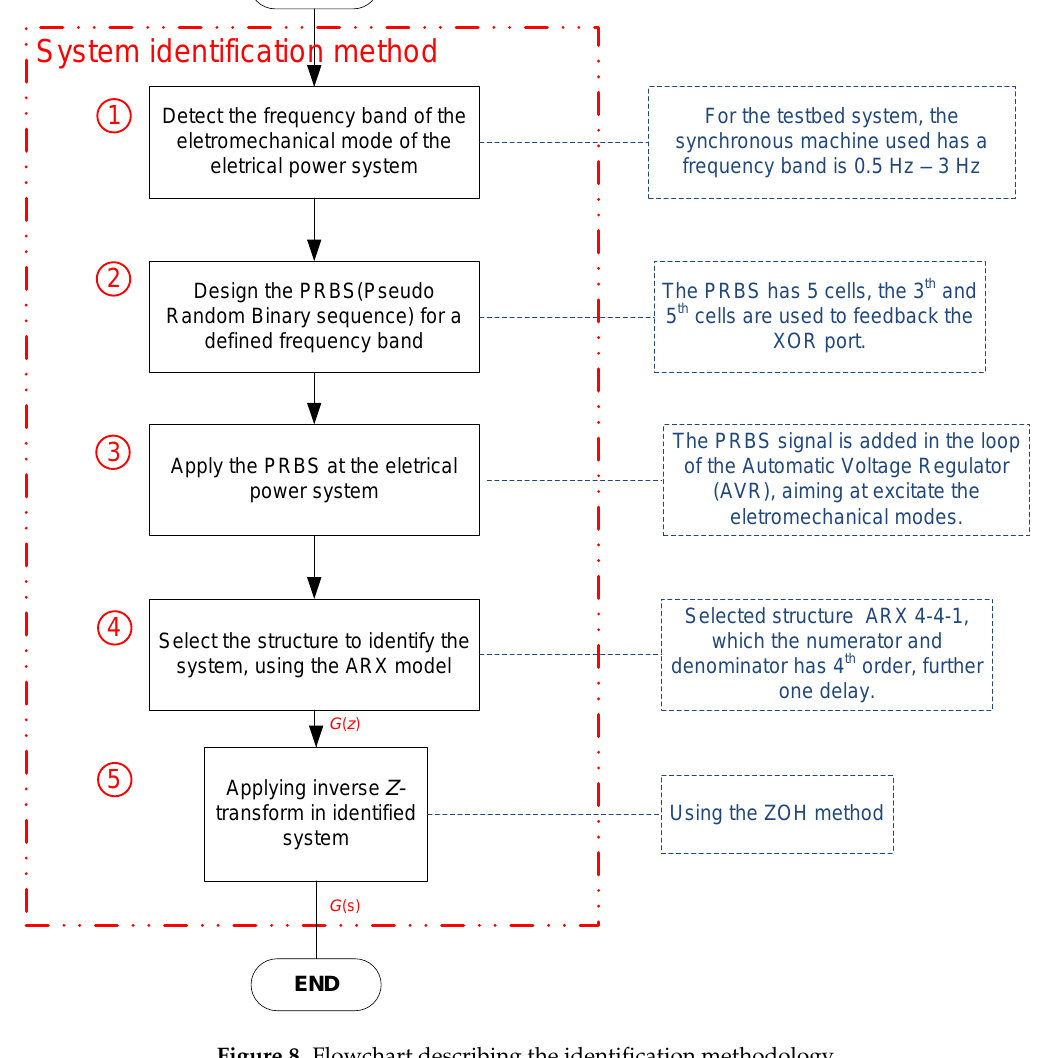
(28) Table 4. Parameters values for the designed FOPSS and Conventional PSS.